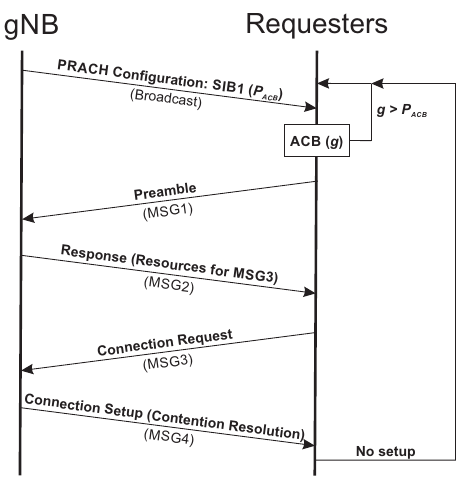
Figure 1. New Radio (NR) Random-Access